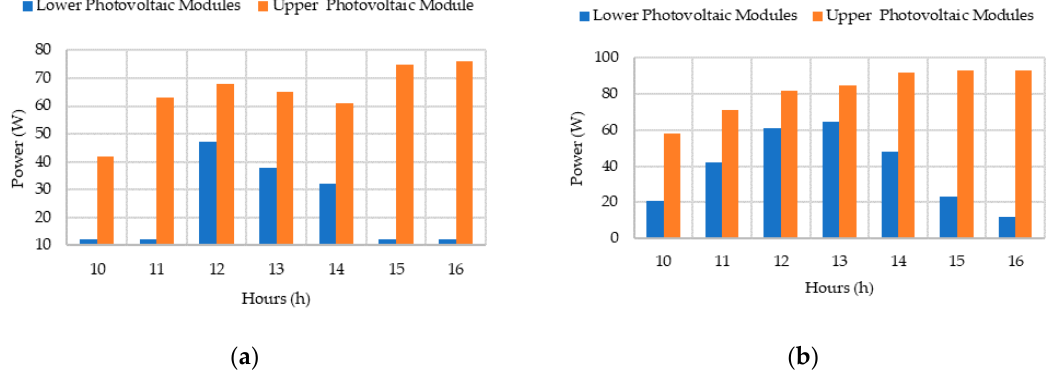
Figure 5. Electric power produced by each PowerCollector™ panel in the: ( a ) non-cooling system and ( b ) in the cooling system.